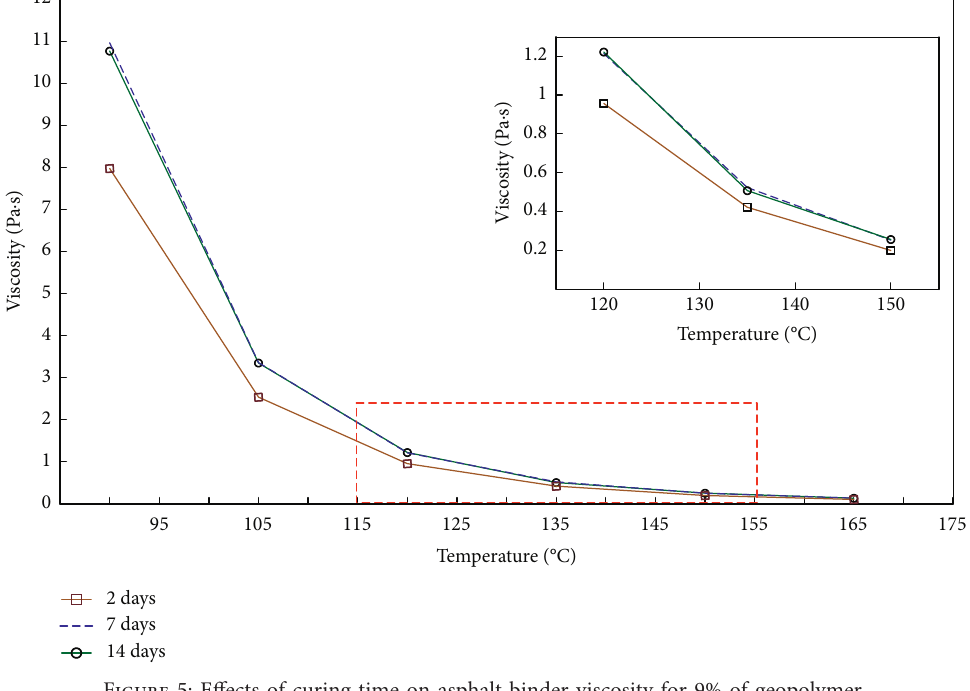
Figure 5: Effects of curing time on asphalt binder viscosity for 9% of geopolymer.